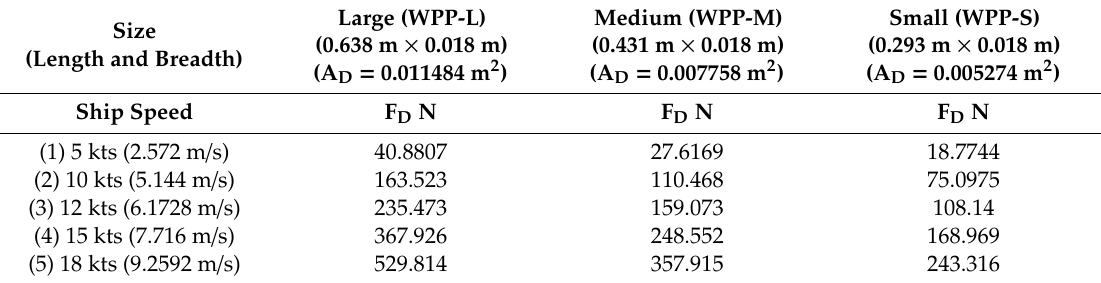
Table 3. Results of F D